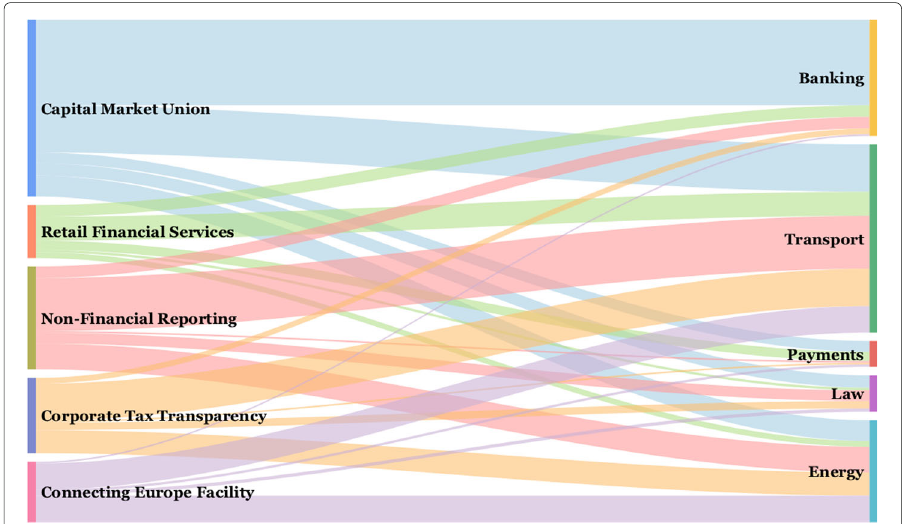
Fig. 4 Relations between the topic communities and tag clouds. The Sankey diagram links the detected topic communities (left-hand side) to the clusters of the self-described goals and activities (right-hand side). We observe no significant correspondence between the topic communities and clusters, also confirmed by quantitative